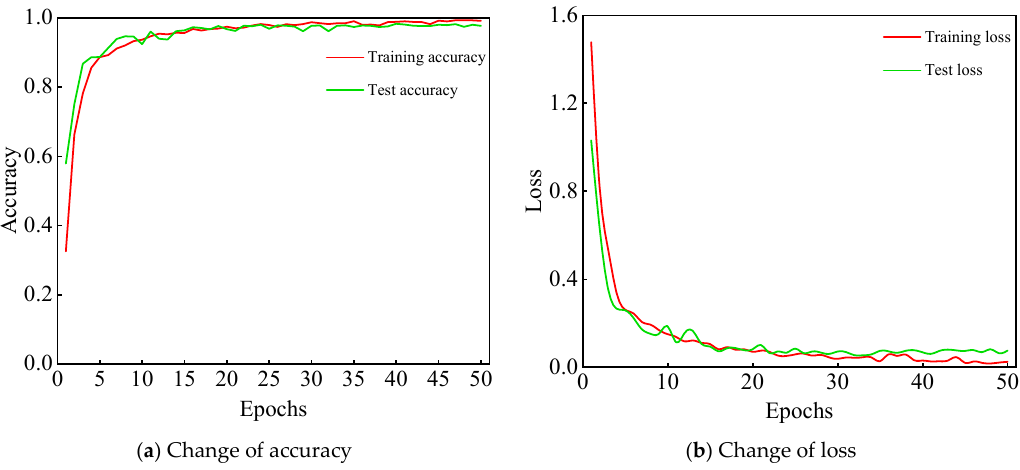
Figure 8. The curve of accuracy and loss error.